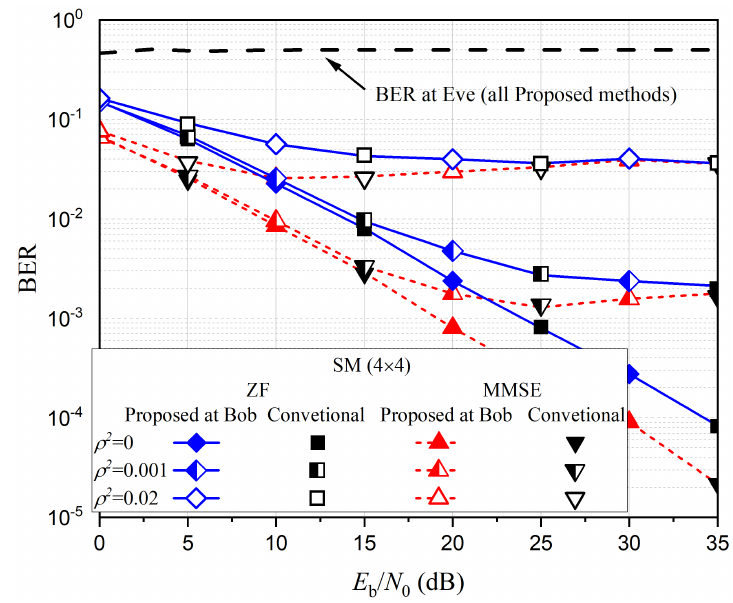
Figure 5. BER performance comparison of various SM schemes with channel estimation